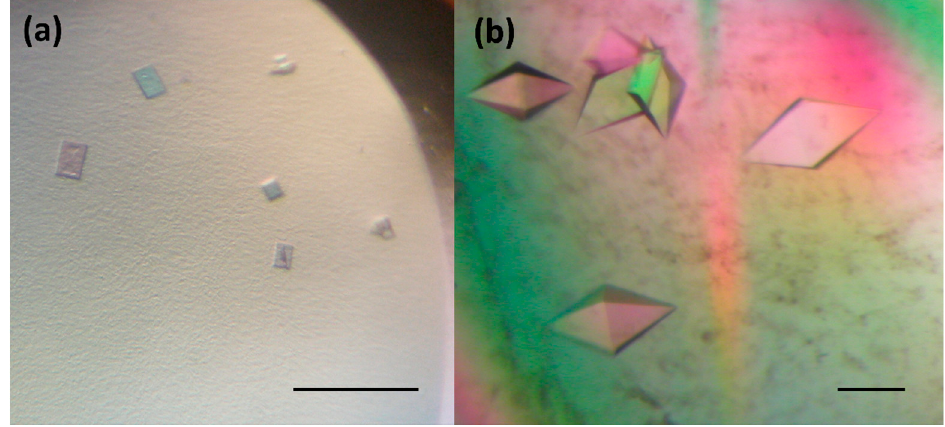
Figure 2. DbeA ∆ Cl crystals used for di ff raction analysis: ( a ) small 3D crystals grown at 26.5% (w / v) Figure 2. DbeA Δ Cl crystals used for diffraction analysis: (a) small 3D crystals grown at 26.5% (w/v) hexanediol and ( b ) big 3D crystals developed by random seeding experiments. The scale bar represents hexanediol and (b) big 3D crystals developed by random seeding experiments. The scale bar 100 µ represents 100 µm.